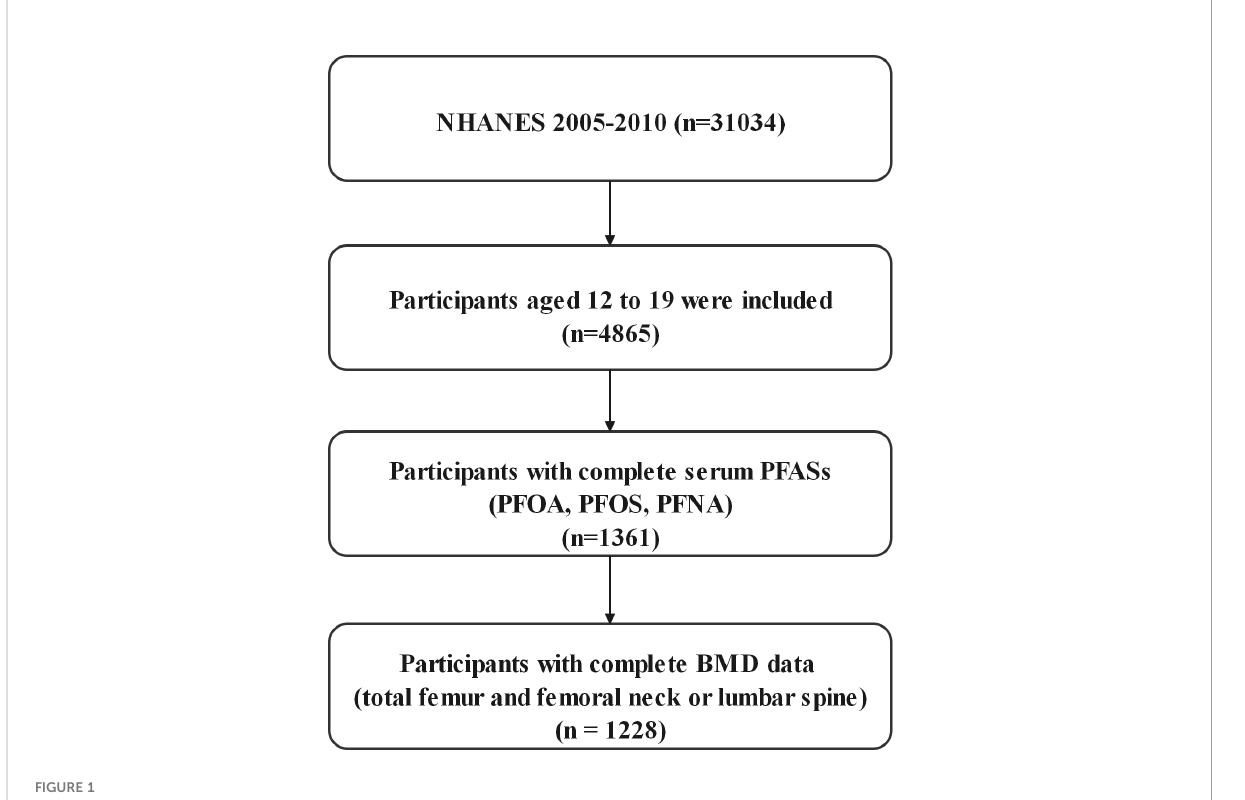
FIGURE 1 Flow chart